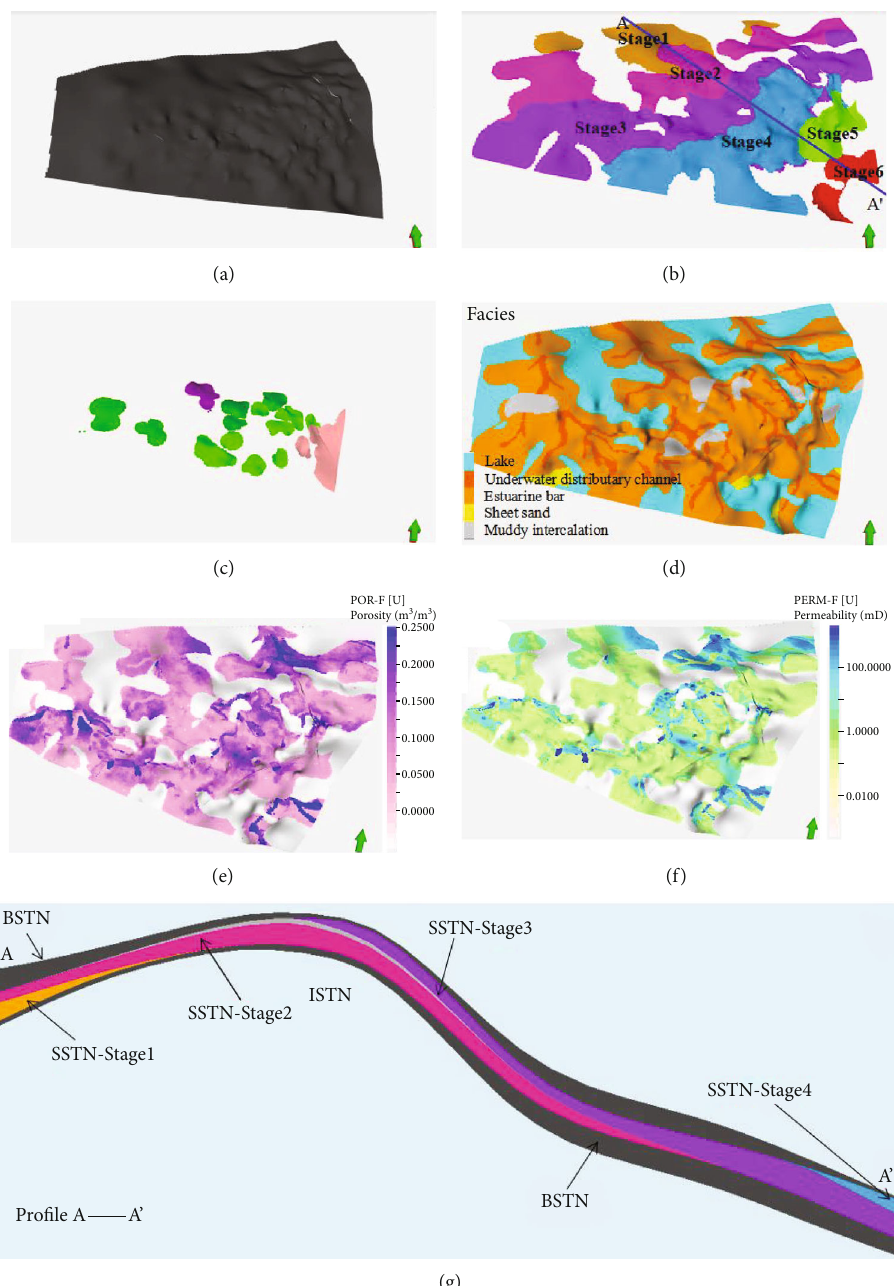
Figure 14: Result of “ sandwich ” layer point coincidence modeling technology for VII-15 member: (a) barrier layer sedimentary time unit; (b) sand bed sedimentary time unit; (c) interbed sedimentary time unit; (d) facies model; (e) porosity model; (f) permeability model. (g) The section shown in